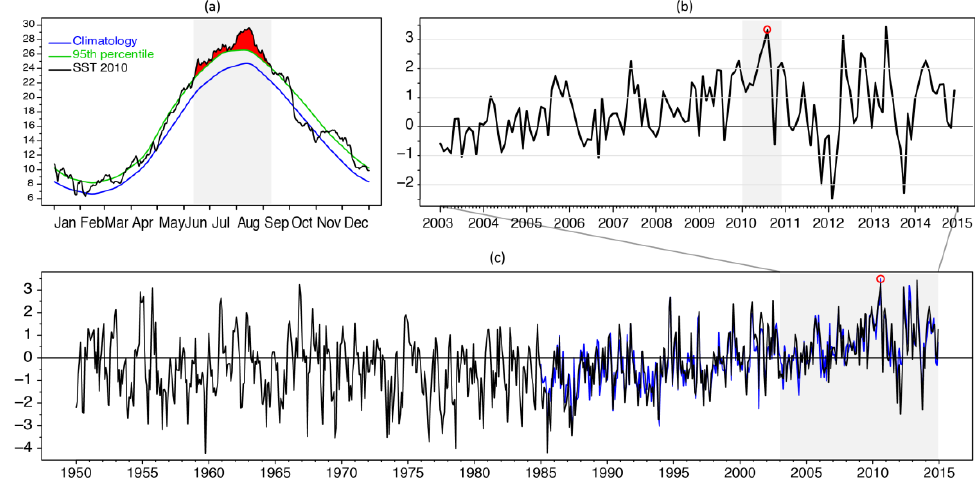
Figure 2. SST series in Sevastopol Bay (°C): ( a ) The climatology (blue), 95th percentile marine heat wave (MHW) threshold (green) and time series (black) for 2010. The red filled area indicates the period of time associated with the MHW; ( b ) Monthly averaged anomalies over the study period 2003 – 2014 with respect to the 1985 – 2014 monthly climatology as recorded by in situ observations; ( c ) As in ( b ) but over the period 1950 – 2014. Black and blue lines in ( c ) show the in situ and satellite observations, respectively.